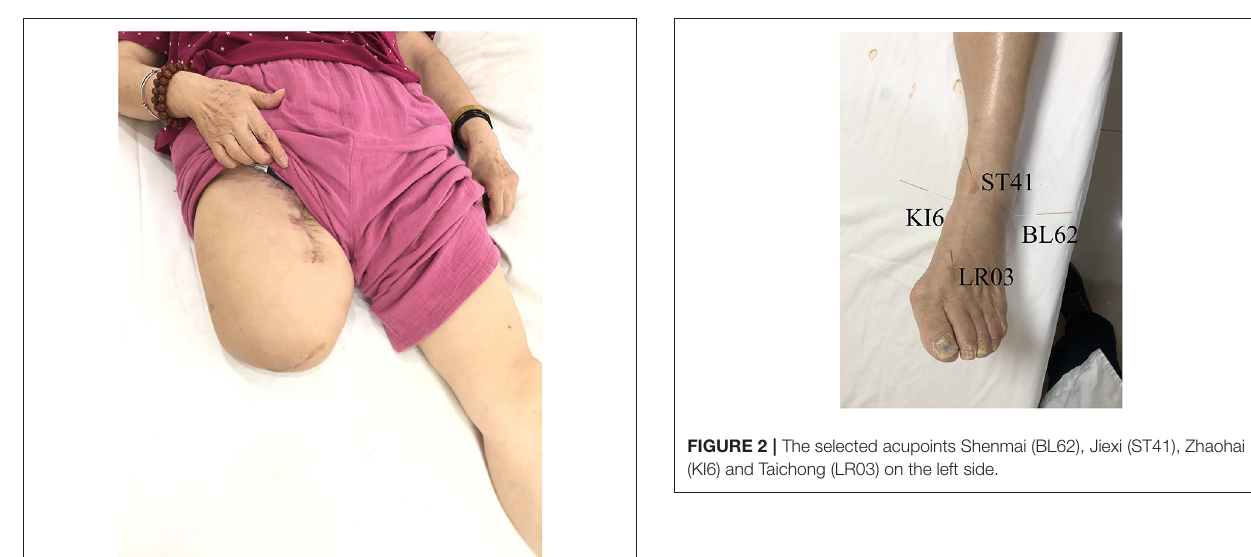
(KI6) and Taichong (LR03) on the left side were needled by stainless steel acupuncture needles (diameter 0.18 mm; length 13 mm; Suzhou Medical Appliance Factory, China). The needles were twirled after insertion and every 10 minutes thereafter to achieve de qi (heaviness, soreness, distension, or numbness the needle), and retained for 30 minutes ( Figure 2